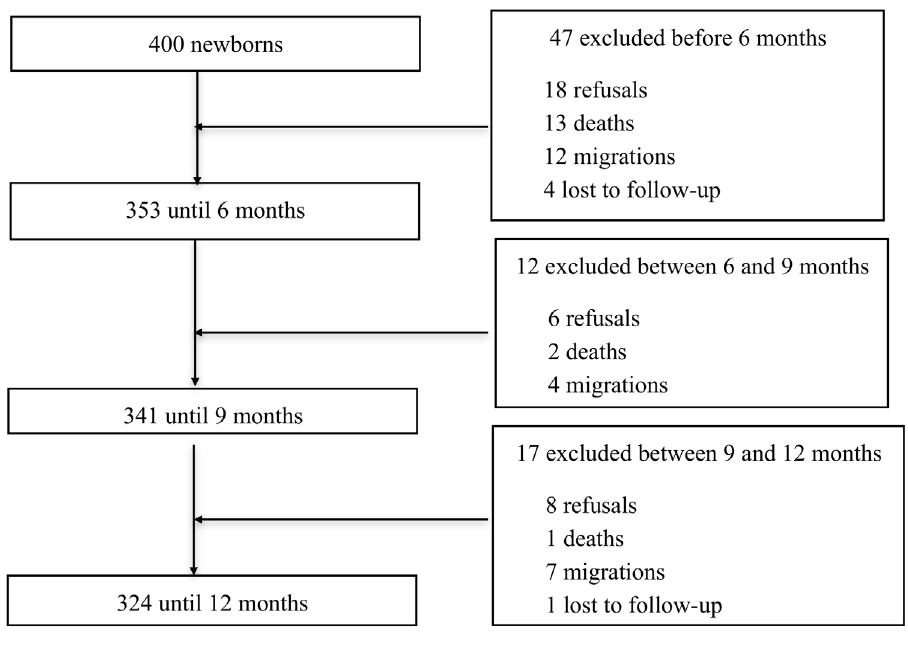
Fig 1. Infant follow-up.